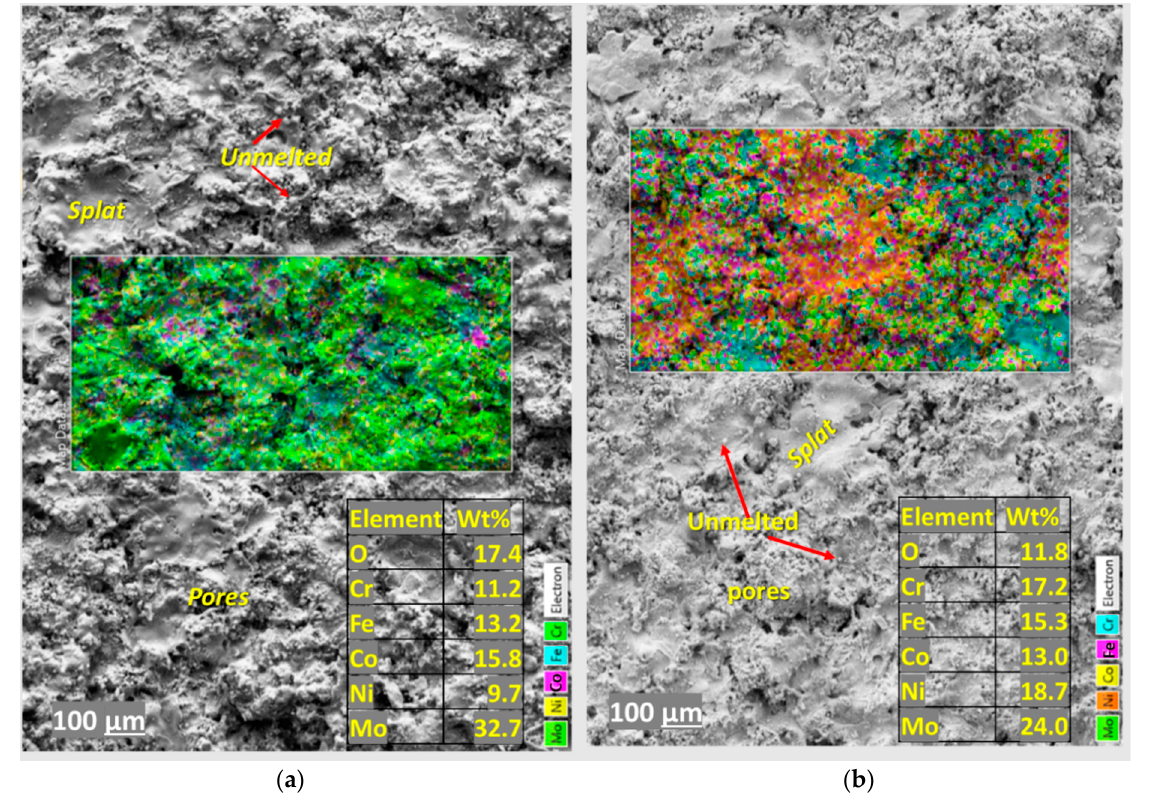
Figure 1. Top surface morphologies, elemental concentration and surface maps of the as-sprayed ( a ) HVOF-HEA_Mo 27 , and ( b ) HVOF-HEA_Mo 20 coatings.